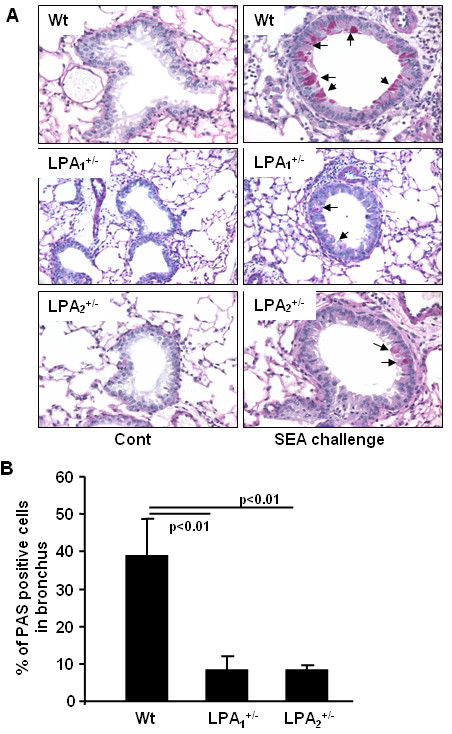
LPA1+/- and LPA2+/- mice exhibit decreases in goblet cells. A) Representative PAS staining sections from Schistosoma mansoni eggs unchallenged and challenged wild type, LPA1+/-, and LPA2+/- mice (n = 4-6) are shown. B) Percentage of PAS positive goblet cells in each bronchia (n = 3-5) were calculated.